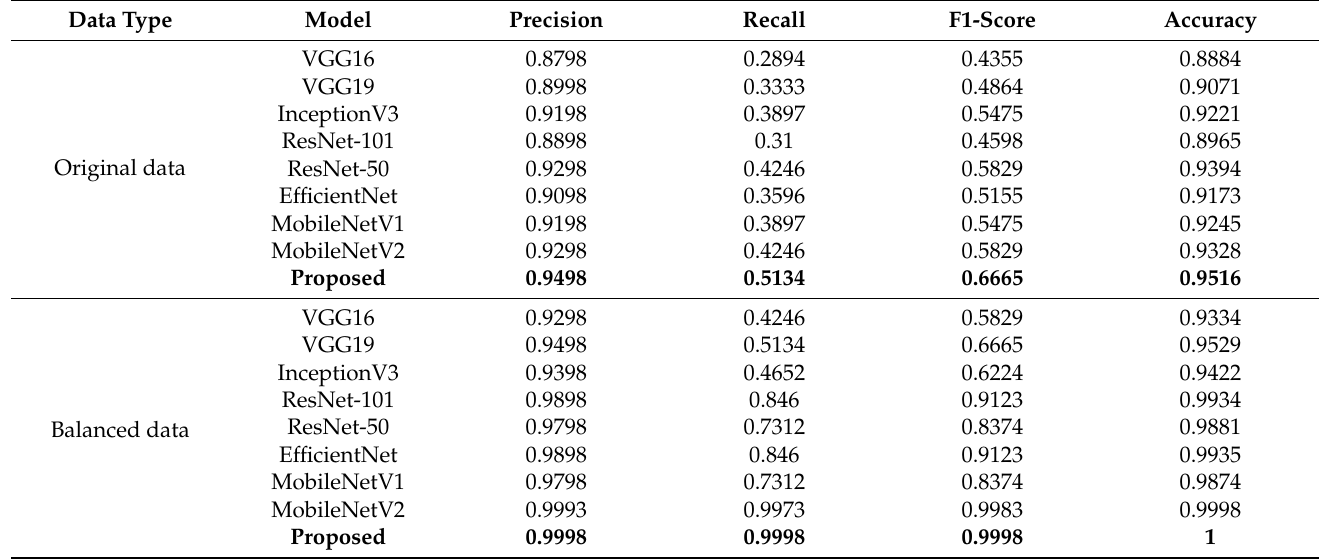
Table 6. The detailed comparative analysis of different models over the RMFR balanced and unbal- anced dataset.